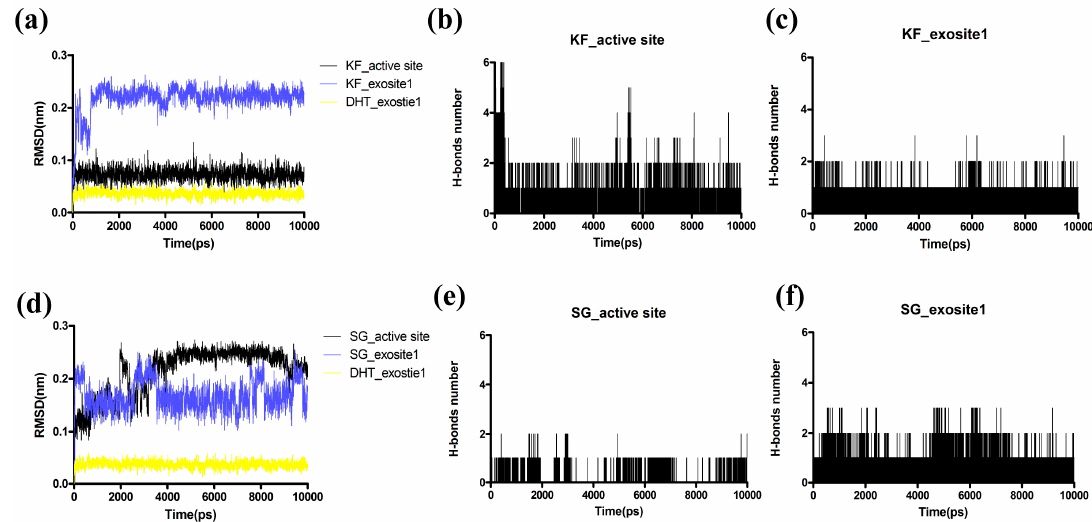
Figure 7. ( a ) and ( d ) Root mean square deviations (RMSD) of KF, SG and DHT (reference compound) during the 10 ns of MD simulation. The number of H-bonds of ( b ) KF and ( e ) SG interact with the active site of Ctsk. The number of H-bonds of ( c ) KF and ( f ) SG interacting with the exosite 1 of Ctsk.